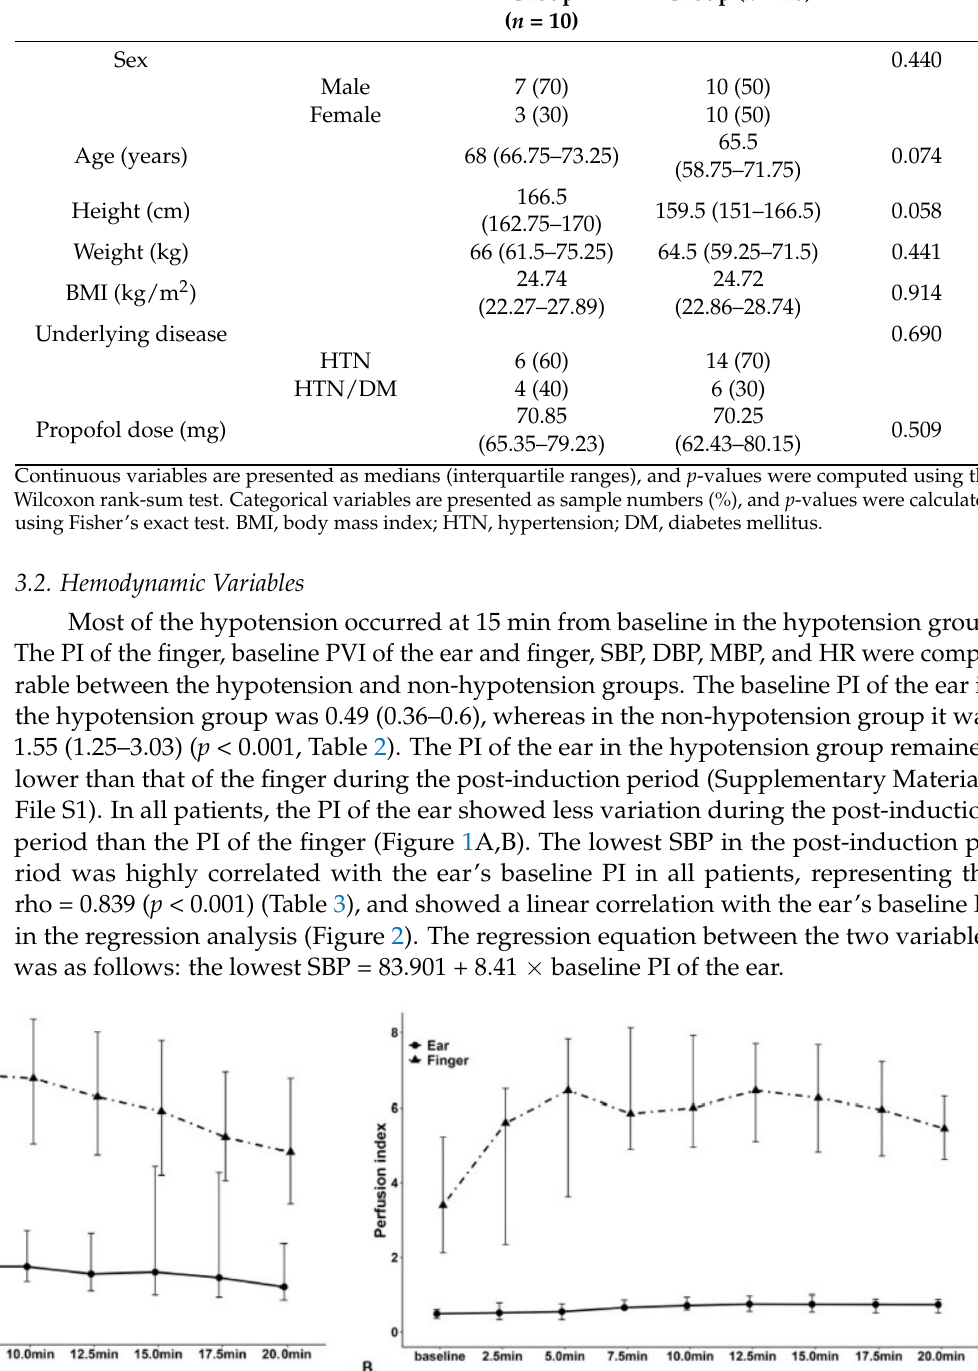
Figure 2. The linear correlation between the baseline PI of the ear and the lowest SBP (mmHg) of the patients. PI, perfusion index; SBP, systolic blood pressure. Table 2. Comparison of baseline hemodynamic data between patients with and without hypoten- sion after the induction of anesthesia. Variable